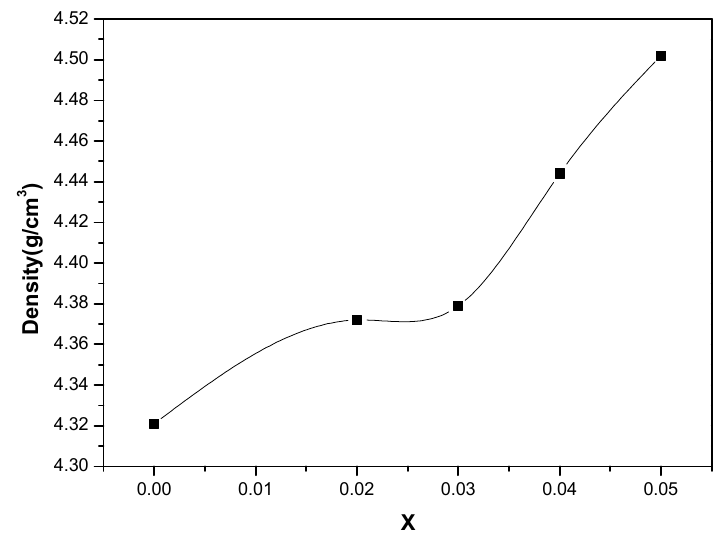
Figure 3. Density of specimens with x.